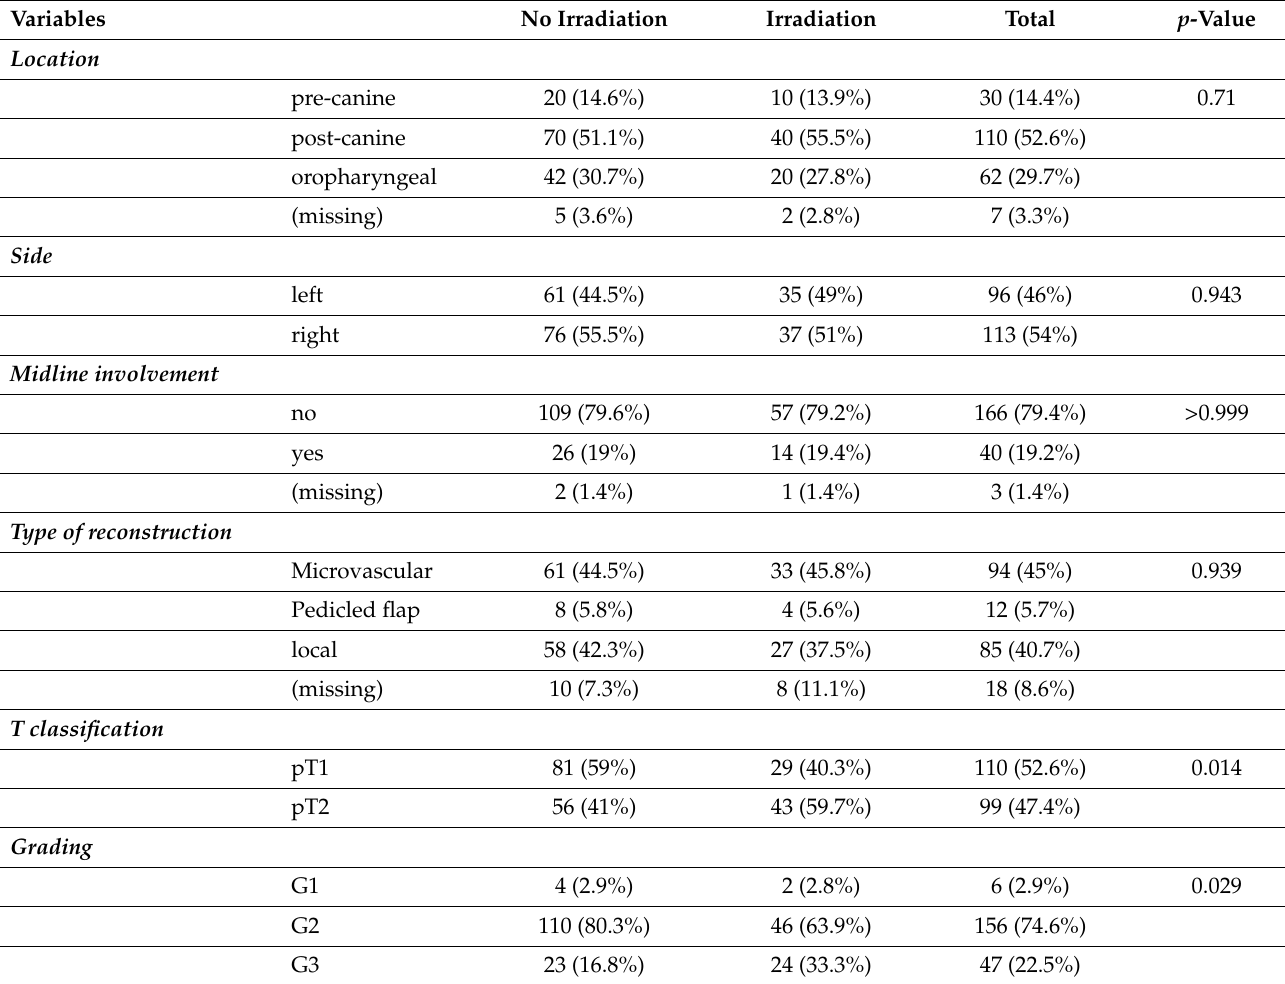
Table 1. Patient and treatment